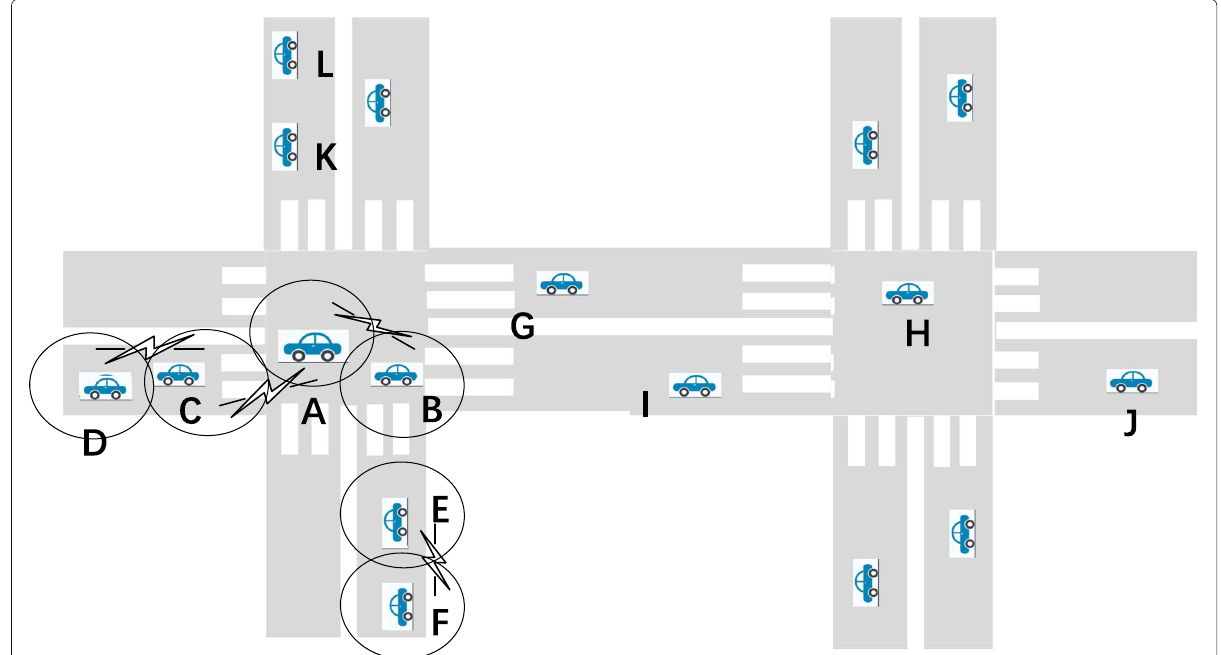
Fig. 7 Vehicle-based self-organizing network based on Manhattan motion